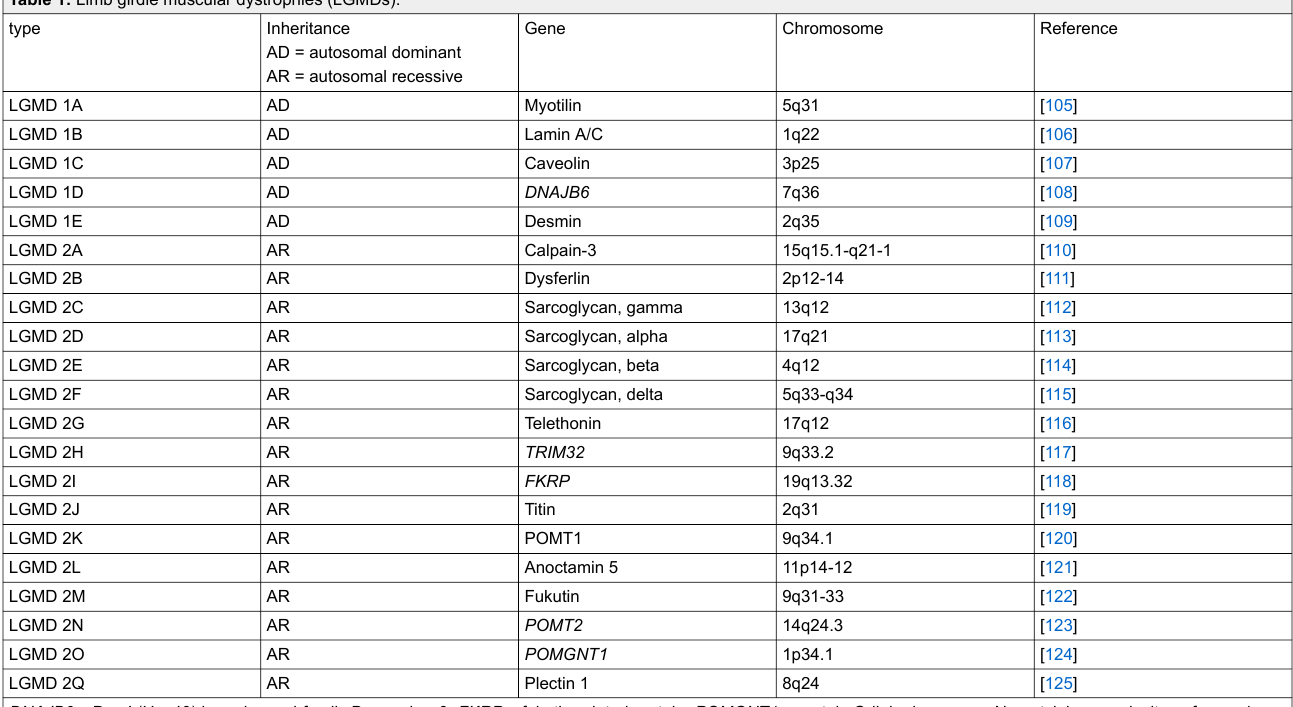
Table 1: Limb girdle muscular dystrophies